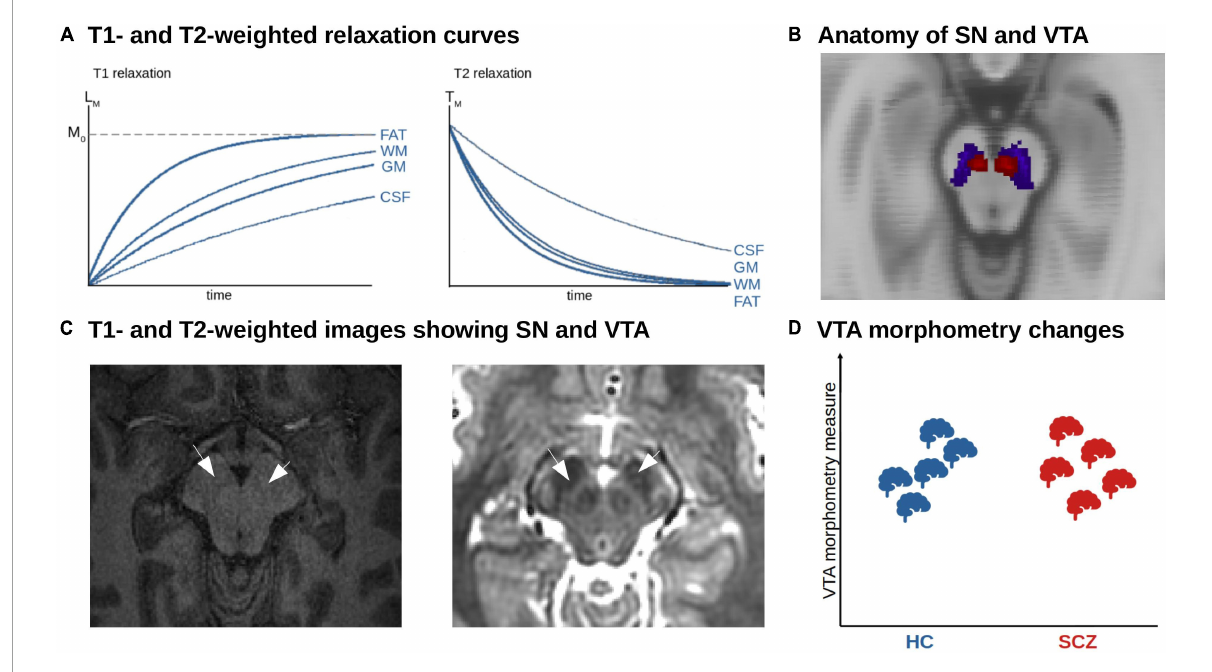
FIGURE3 MRI-based morphometric analysis of dopaminergic nuclei in schizophrenia. (A) T1- and T2-weighted relaxation curves. The figure shows the recovery of the longitudinal magnetization (T1 relaxation). Tissues with a short T1 relaxation time such as fat and white matter (WM) recover faster and produce a stronger signal. The T2 relaxation reflects the decay of transverse magnetization. Tissue with a short T2 relaxation decays more quickly and produces a weaker signal. (B) Anatomy of SN and VTA. Axial view of the SN (blue) and VTA (red) derived from a probabilistic atlas shown on the MNI anatomical template (158). (C) T1- and T2-weighted images showing SN and VTA. Axial T1w (left) and T2w (right) structural imaging of the brainstem. The arrows point to the area of SN and VTA. (D) Unclear morphometric changes of dopaminergic nuclei in schizophrenia. Due to the low number of studies and methodological challenges, no clear trends have emerged so